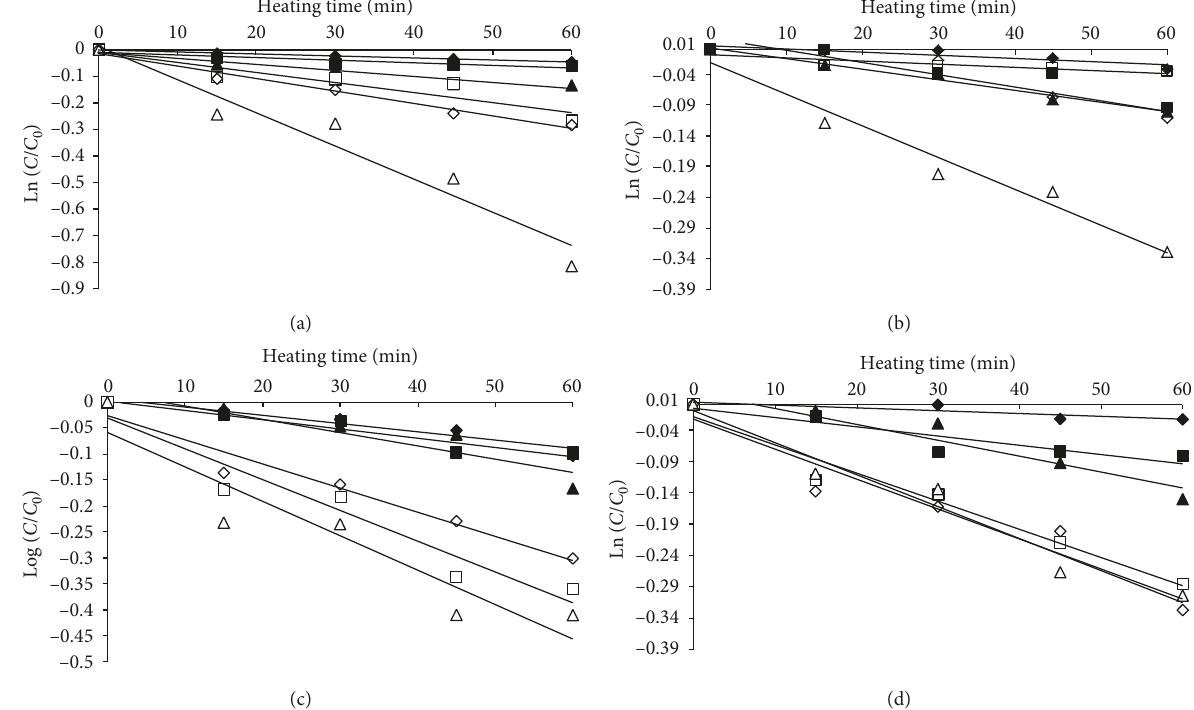
Figure 2: Isothermal degradation of anthocyanin in PW (a), PCA (b), PS (c), and PM (d) as described by first-order kinetic model at different temperatures (